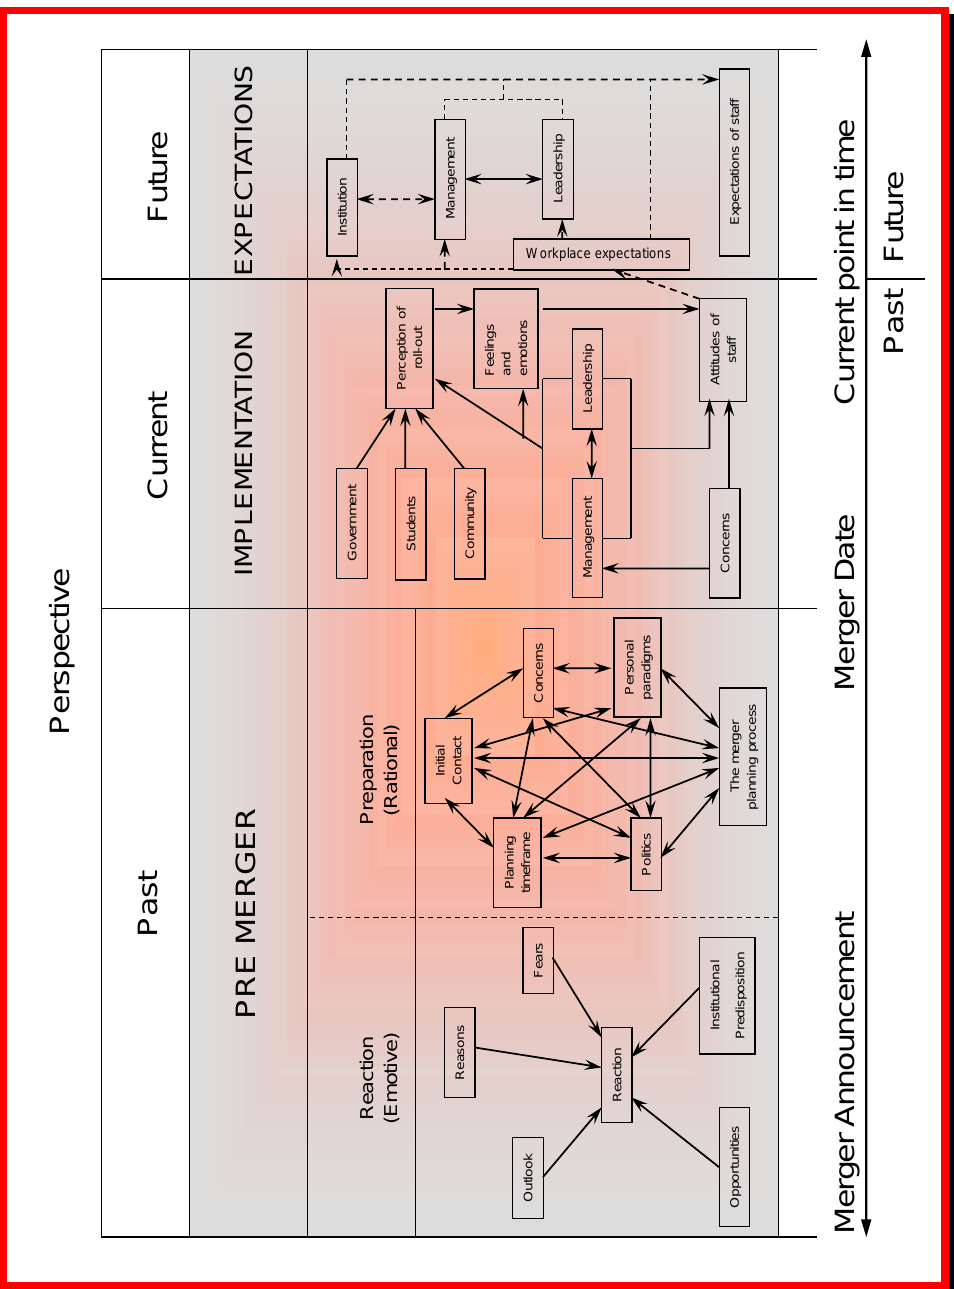
Figure 1: The reflective experience of mergers (REM)